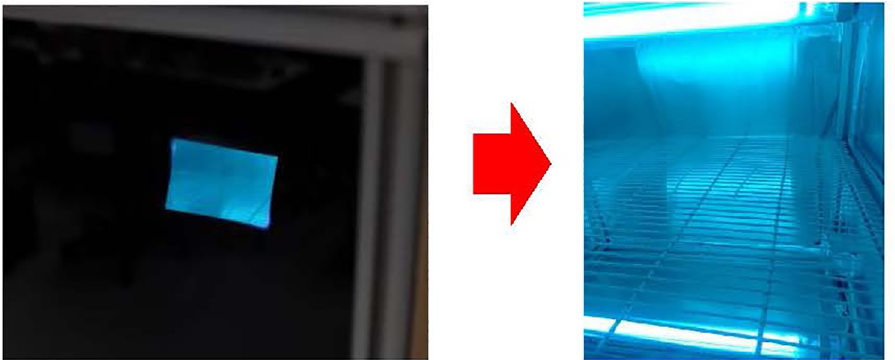
Fig 8. Decontamination with UVC irradiation at 430 μ Watt-sec/cm 2 for 1 min for 5, 10, 30 and 60 cycles.